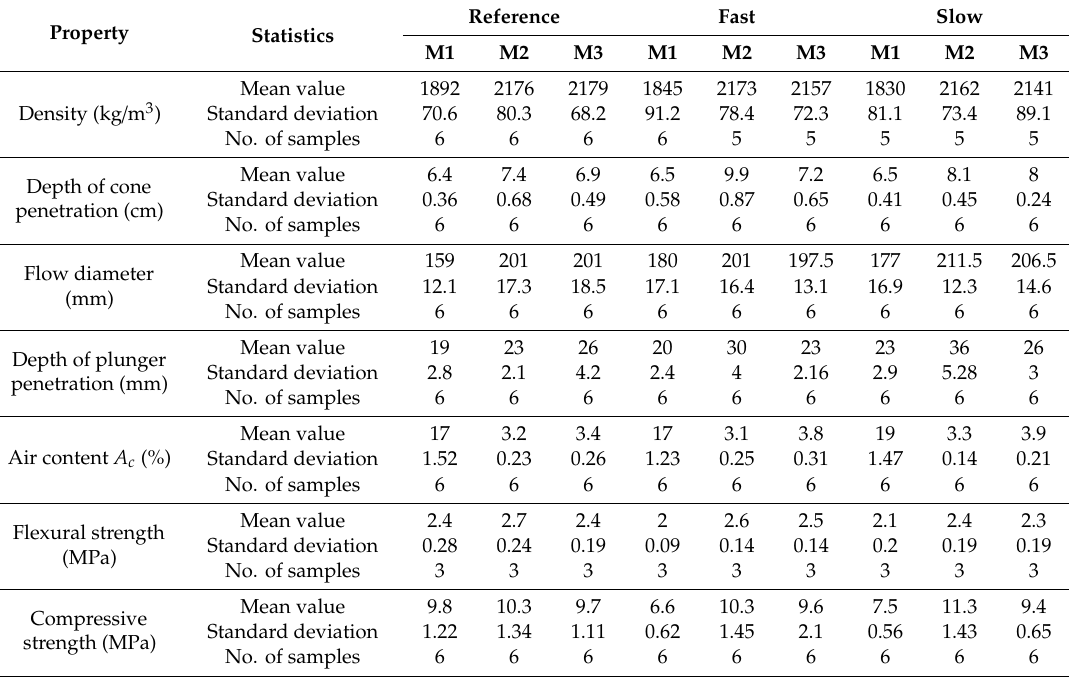
Table 18. Results of tests of the influence of mixing intensity on properties of masonry